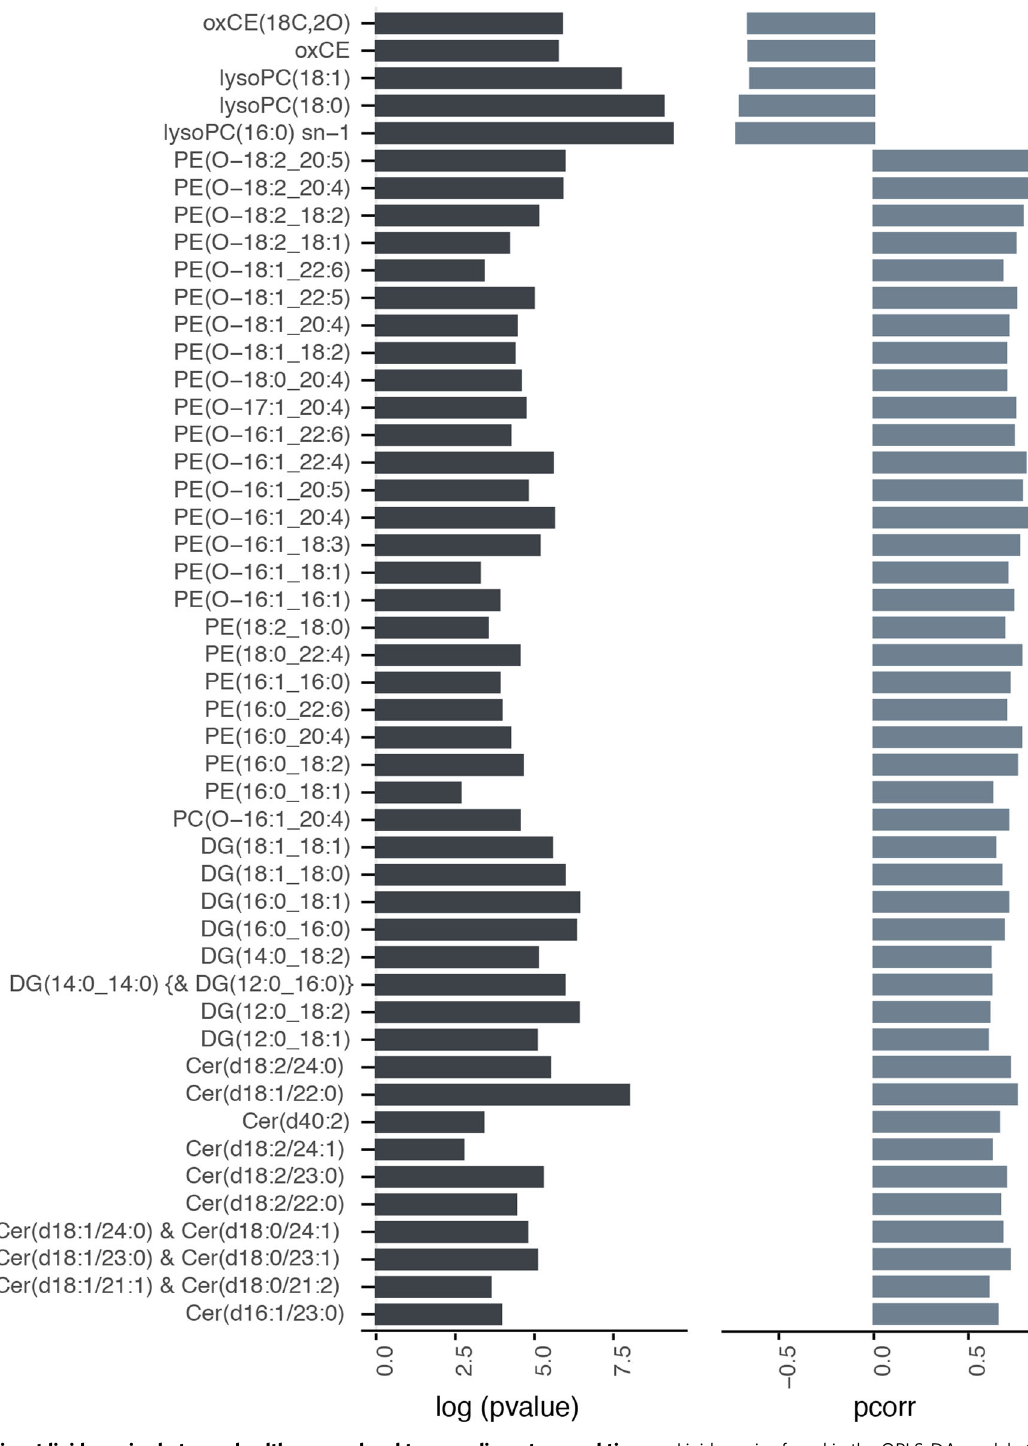
Fig. 1 Discriminant lipid species between healthy-normal and tumor-adjacent-normal tissues. Lipid species found in the OPLS-DA models (ESI + and ESI − ) to be signi fi cantly different in breast tissue collected from healthy women ( n = 19) and those with breast cancer ( n = 42). Left panel, bar plot presenting the log( p value) from the t test (two-tailed; assuming unequal variance) comparing the two groups. Right panel, bar plot indicating the p (corr) values obtained from the OPLS-DA models built on the lipidomic pro fi le (negative p (corr) indicates the lipid feature is more abundant in the tissue from cancer patients compared to healthy controls). Top fi ve features in the list are uniquely present in tissues from cancer patients. Cer ceramide, DG diacylglycerol, lysoPC lysophosphatidylcholine, oxCE oxidized cholesteryl ester, PC phosphatidylcholines, PE Integrated analysis of the microbial and lipidomic data was also Gammaproteobacteria (unclassi fi ed) and Comamonodaceae were performed without prior variable selection using Pearson ’ s signi fi cantly inversely correlated with the abundance of Cer and correlation coef fi cients (Fig. 3). Results from this analysis were PEs. Staphylococcus did not associate with ceramides but evaluated with and without false discovery rate (FDR) correction. exhibited negative correlations with PEs. Bacillus was negatively